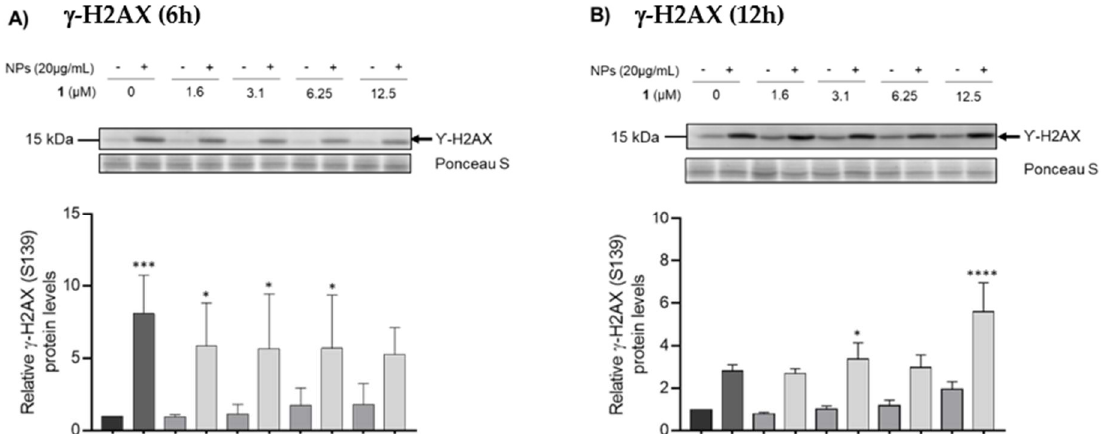
Figure 6. Immunoblotting analysis of γ -H2AX (Ser139) intracellular levels . This assay allows for the assessment of the DNA damage after the incubation of GC-1 cells with 20 µg/mL of ZnO NPs and different concentrations of chalcone 1 (0–12.5 µM) per se, and the protective effects of chalcone 1 against the genotoxicity induced by the NPs after ( A ) 6 h and ( B ) 12 h of co-exposure with ZnO NPs. The intracellular protein levels of -H2AX were estimated in relation to protein levels detected in the control condition. Ponceau S staining was used to assess gel loading. * p < 0.05, *** p < 0.001, and **** p < 0.0001 compared to the control group, using one-way ANOVA. All data were expressed as the mean ± SEM of four independent experiments. NPs: nanoparticles.